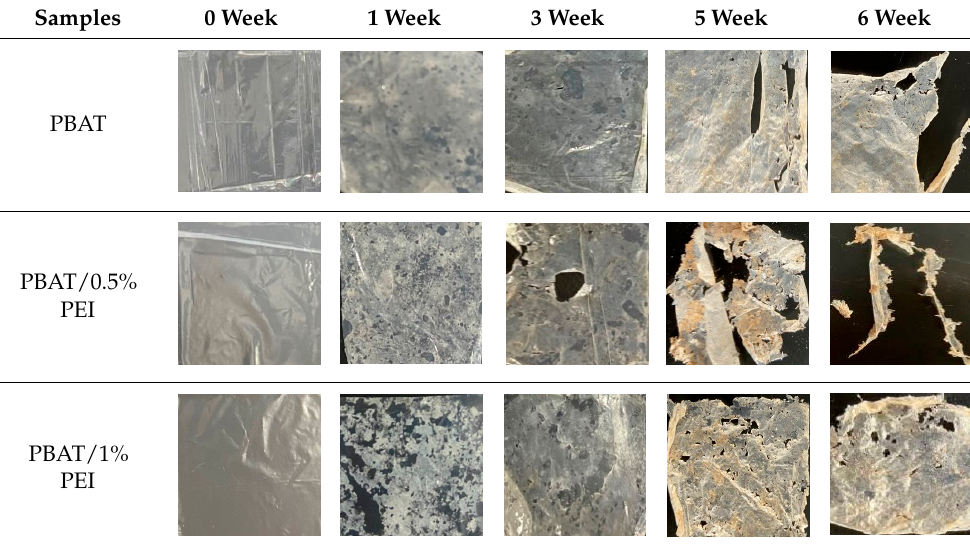
Table 8. Visual aspect of the samples during degradation in soil surface.